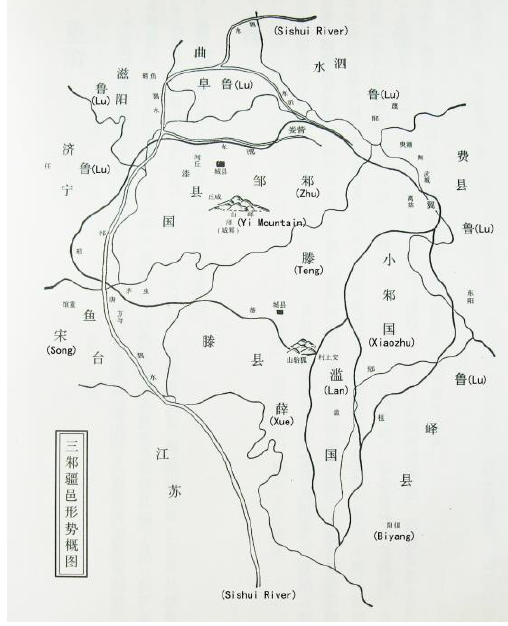
Figure 2. Frontier situation map of “ Three Zhu”